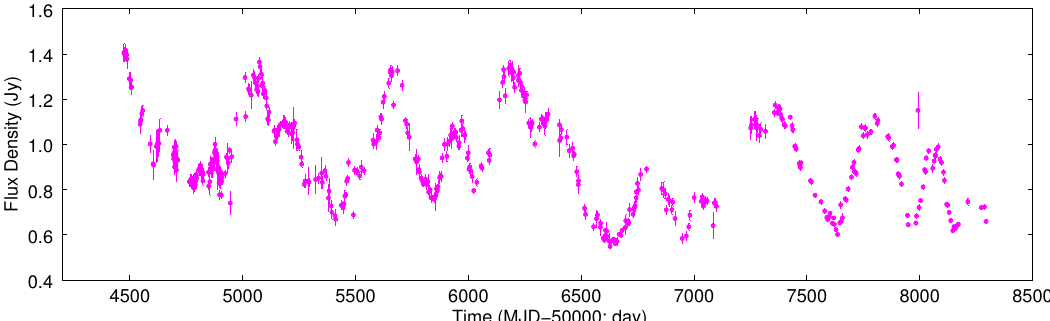
Figure 1. ∼ 10.5-year-long 15 GHz observations of blazar J1043+2408 from